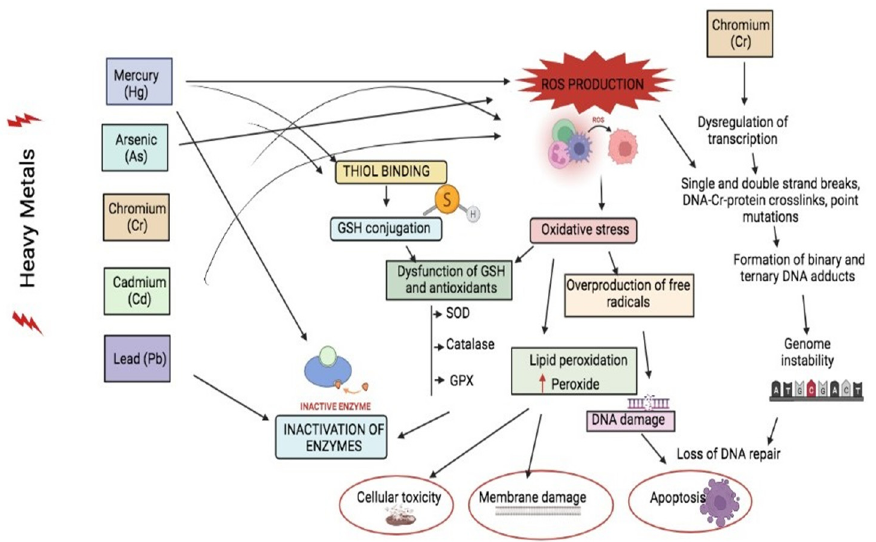
Figure 2. Toxic mechanisms and effect of the cellular level of heavy metals Hg, As, Cr, Cd, and Pb. These heavy metals provoke ROS production inside the cell and cause an imbalance of ROS and antioxidant production, thus causing cellular damage via inactivation of enzymes, apoptosis, genome instability, and DNA damage. Up arrow ( ) indicates increases.